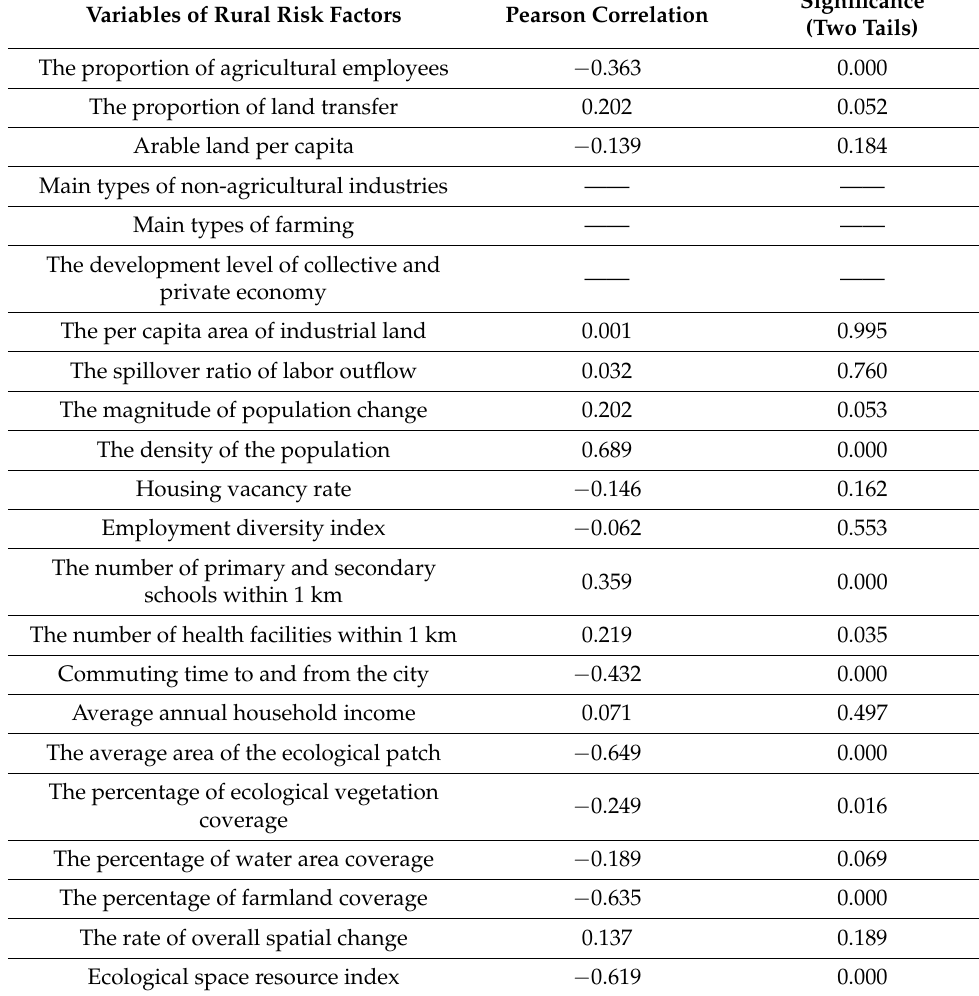
Table 4. Statistical analysis of the correlation between transit traffic network density and rural risk